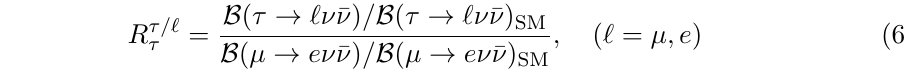
Figure 18 . Left panel: exclusion (shadowed) region in the plane ( c b 1 : 02. Right panel: we display in green the excluded region corresponding to R (cid:28)=(cid:22) (cid:28) the plane ( c b ; c (cid:28) ). We overlap as well the allowed region coming from the ( R D ; R D (cid:3) ) observables. L L We have considered c (cid:22) = 0 : 44. We have used in both plots r = 0 : 75 and m KK = 2 L